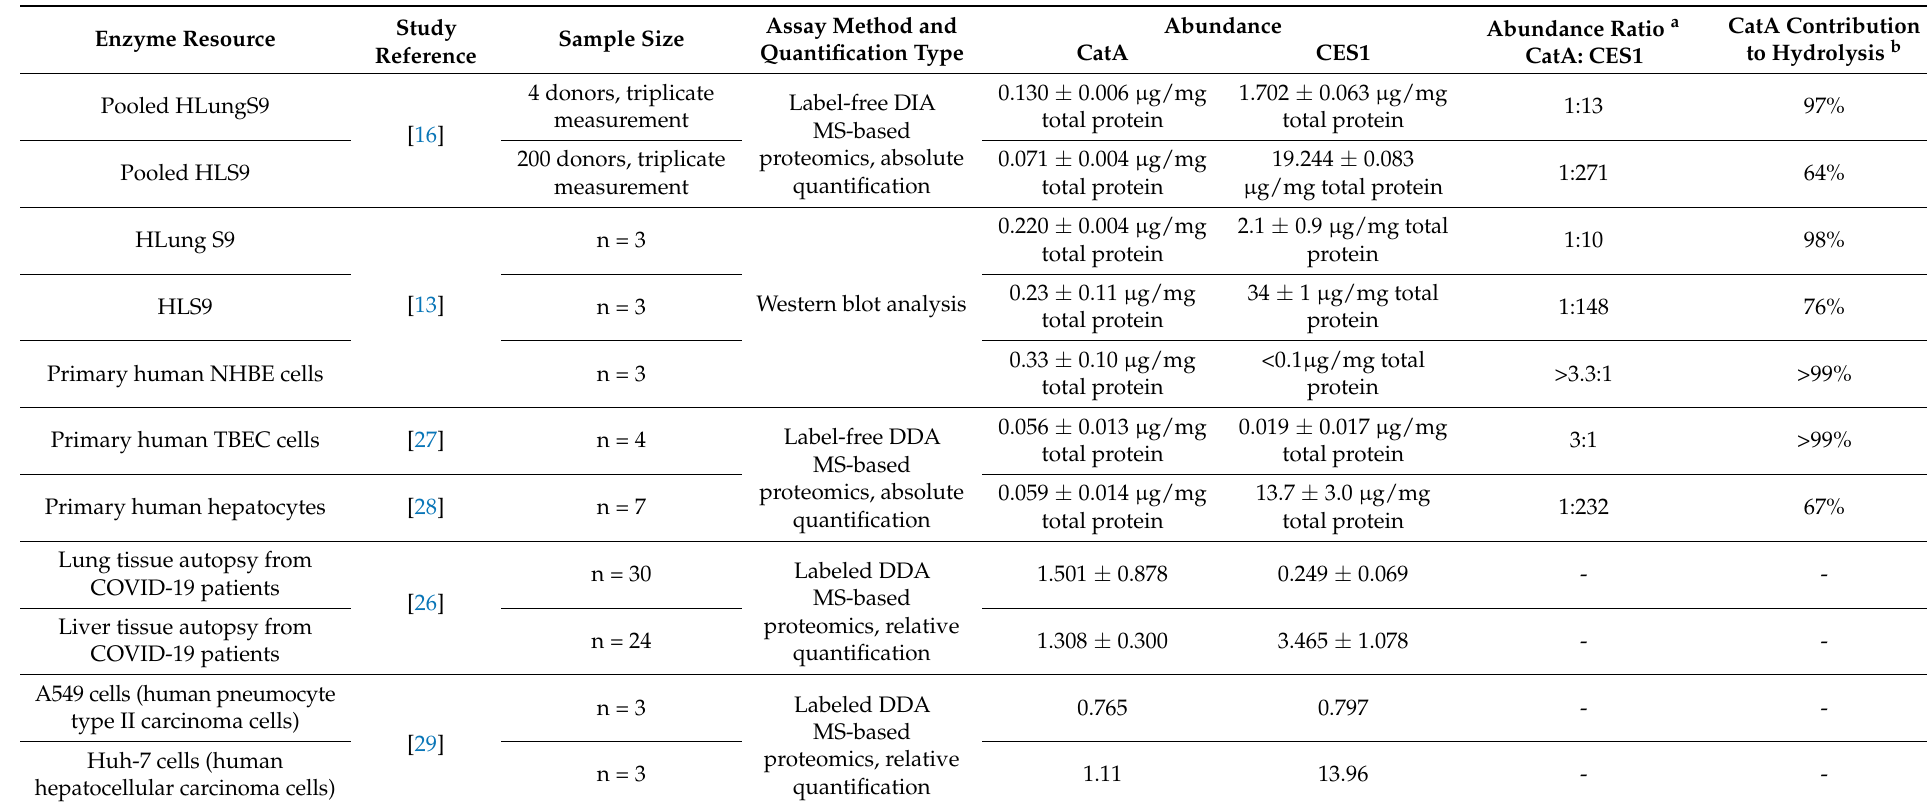
Table 1. Meta-analysis of the protein abundance of CES1 and CatA in human respiratory and hepatic tissues and cells. Enzyme